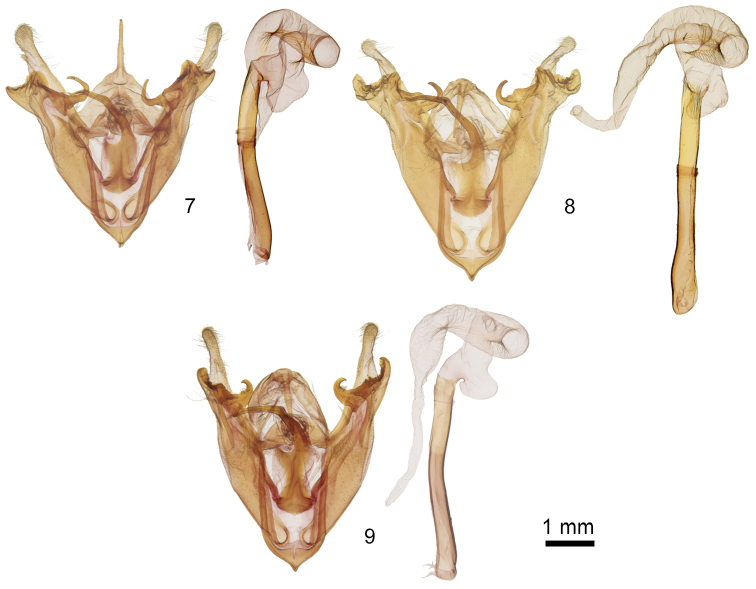
Rhabdorthodes male genitalia, valves and phalluses with everted vesicas 7R.pattersoni8R.durango9R.petersoni.